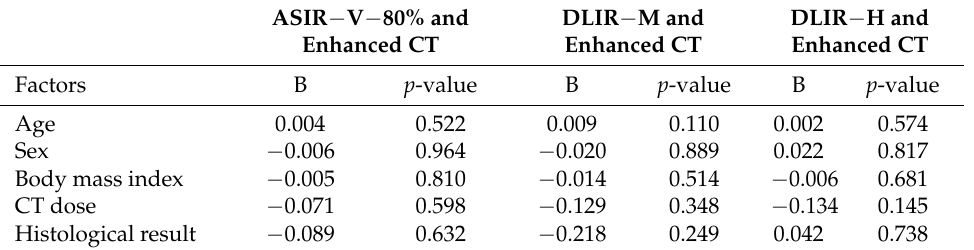
Table 8. Multiple linear regression analysis of influential factors on measurement difference of nonmeasurable lymph nodes between ultra-low-dose CT and contrast-enhanced